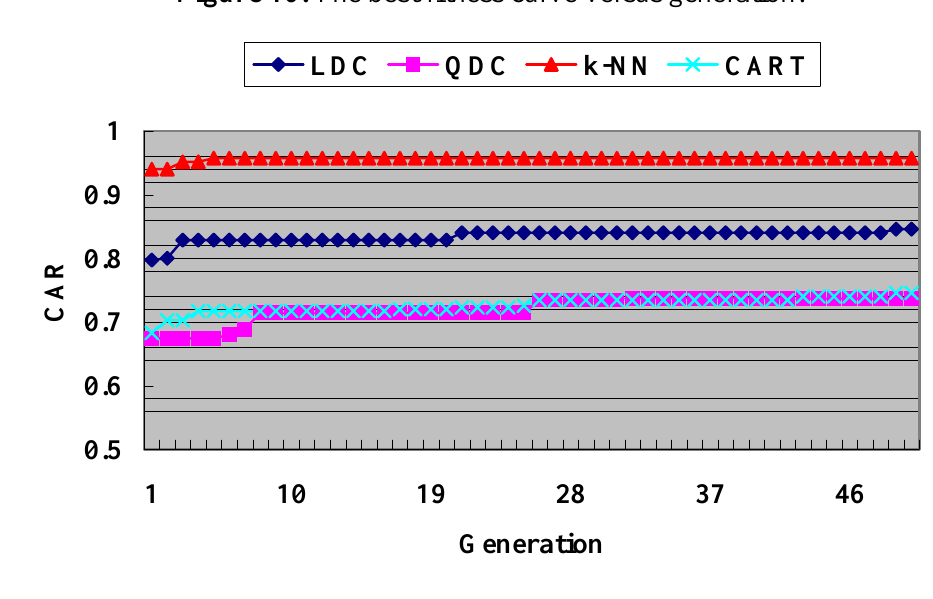
Figure 10. The best fitness curve versus